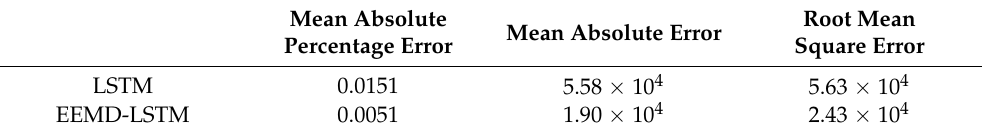
Figure 7. Comparisons of the reported data and the predicted data (EEMD-LSTM model). The predicted results showed that the number of confirmed cases will still increase by 25 April 2021. The red dotted line depicts the hybrid EEMD-LSTM model’s prediction results on the test set which reveals that the number of confirmed cases in California will reach 3,681,150 on 25 April 2021. The asterisk line depicts the reported number of confirmed cases in California with 3,731,677 on 25 April 2021. Table 2. Comparison of the prediction performances between EEMD and EEMD-LSTM models.